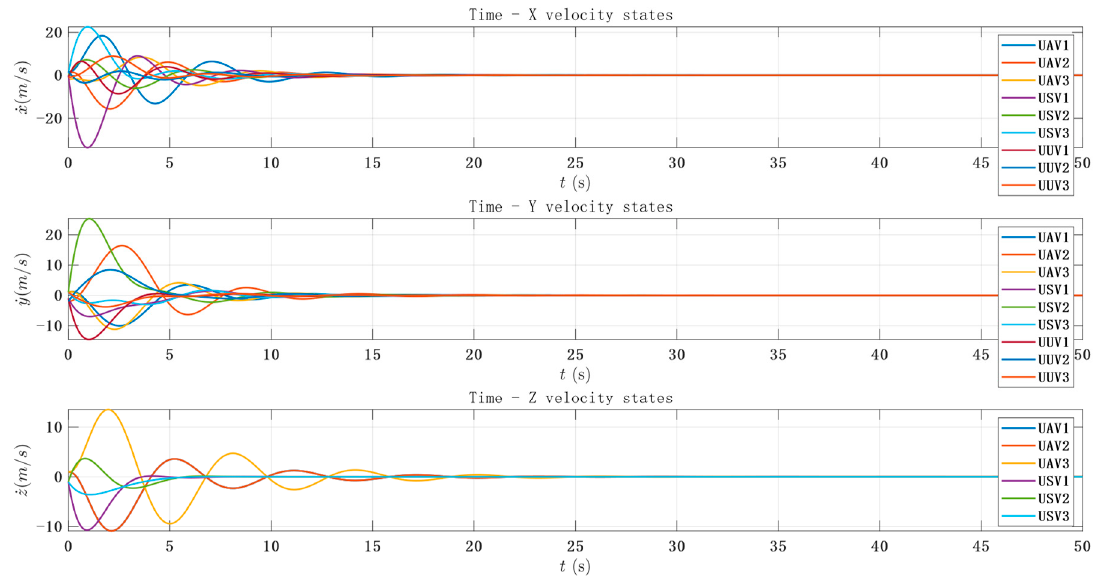
Figure 11. Velocity state with static cooperative optimum formation control.